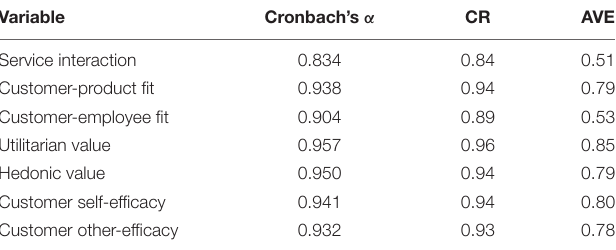
TABLE 1 | Reliability and validity of the main measurement constructs. Variable